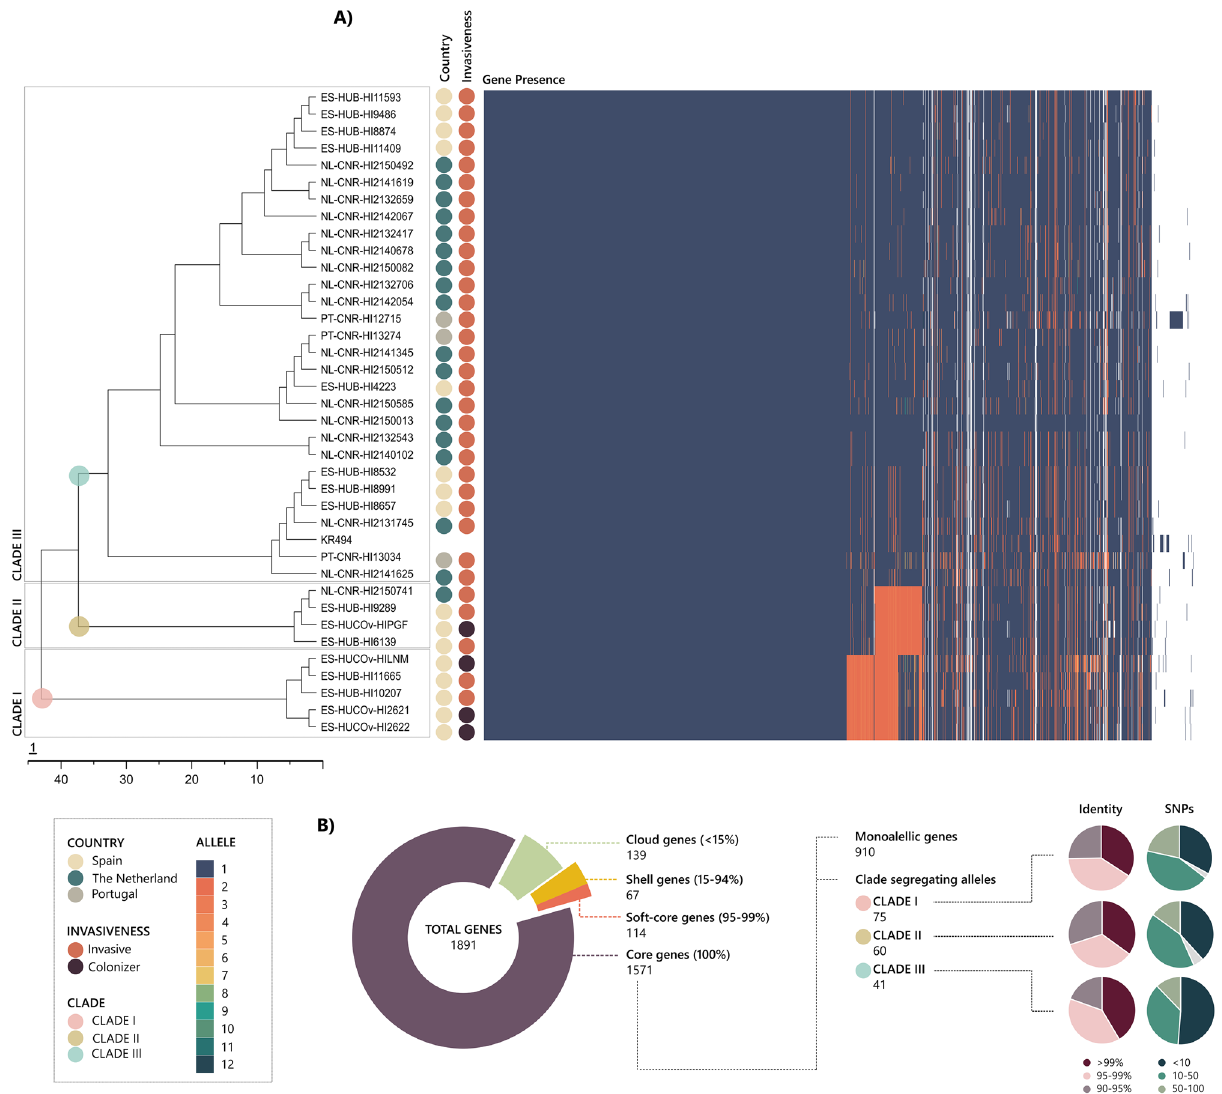
Figure 1. Pangenomic analysis of the 37 H. influenzae serotype f genomes. ( A ) Core-SNP phylogenetic tree, demographic data (country and invasiveness), genes detected, and the assigned allele. Clades I, II and III are indicated by coloured dots. The percentage of strains carrying each gene is presented graphically. ( B ) Distribution of genes detected in H. influenzae serotype f: core genes (100% of genomes), soft-core genes (95–99%), shell genes (15–94%), and cloud genes (< 15%). Core genes were classified as monoallelic (same allele in all the isolates) or clade segregating alleles (an allelic variant exclusive to one clade). The pie charts show the identity and number of SNPs for alleles of each clade in relation to the alleles of the same gene in other